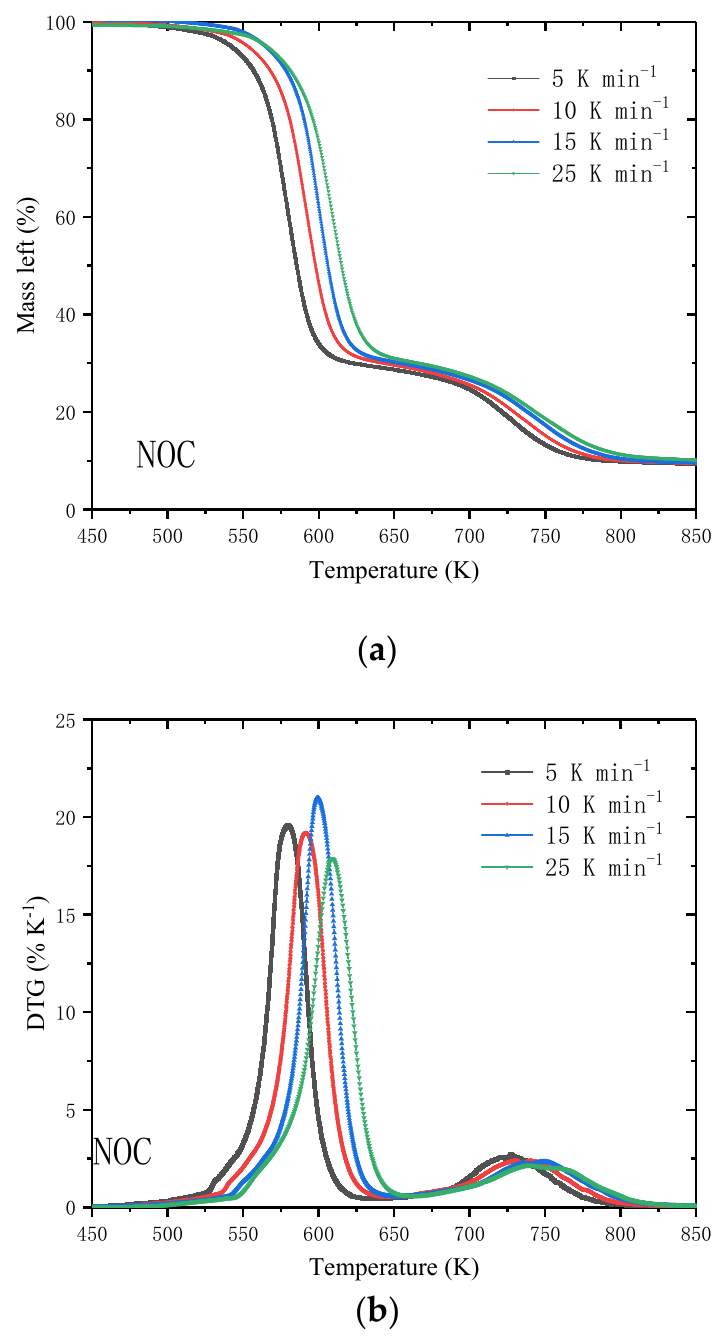
Figure 2. Thermogravimetric and differential thermogravimetry curves of nasal oxygen cannula pyrolysis at different heating rates: ( a ) Thermogravimetric curves; ( b ) Differential Thermogravimetry